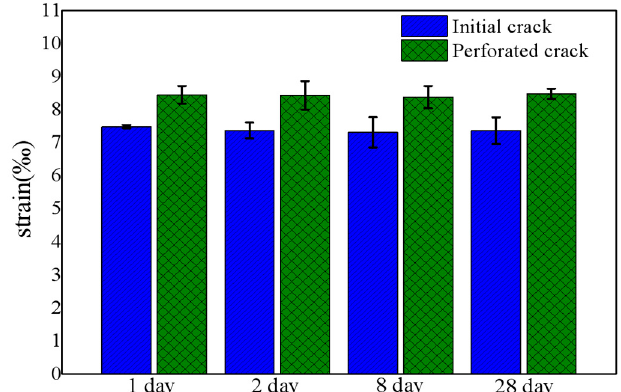
Figure 9. Fracture extensibility of SiN x films at different time.